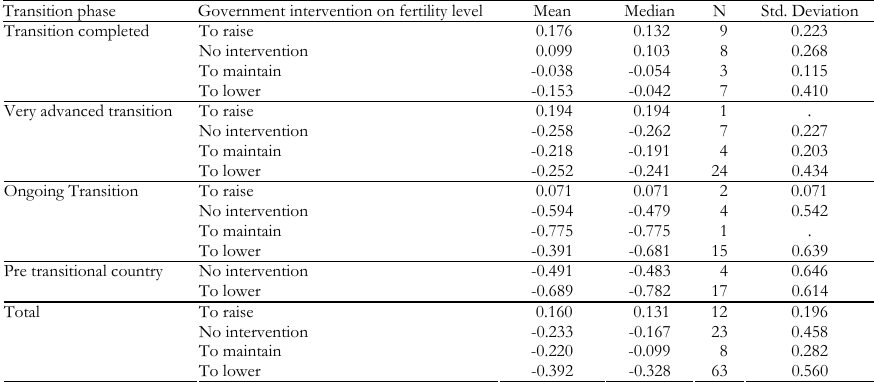
Mean and median scores on factor 1 by transition phase and type of Government intervention on fertility level Transition phase